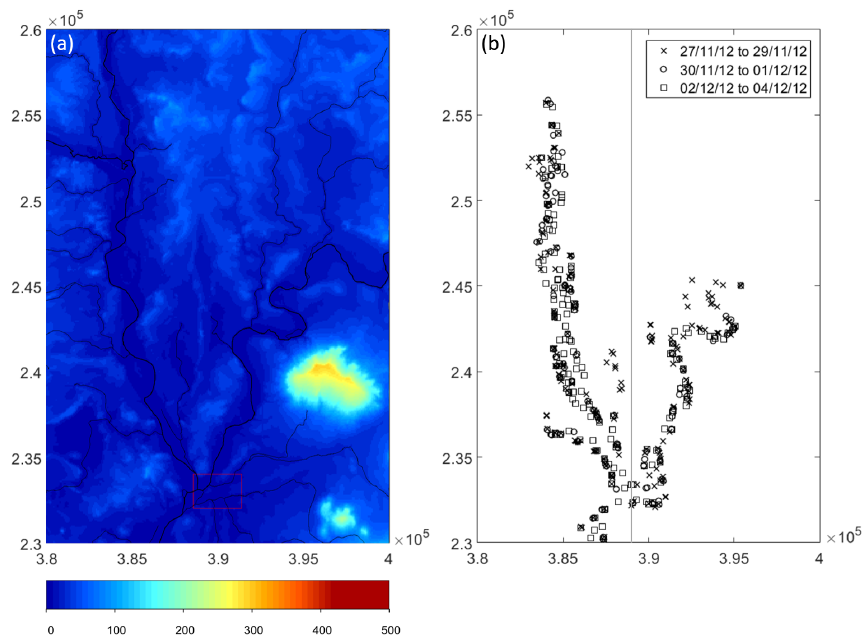
Figure 1. (a) Flood model domain where the colour bar denotes the height in metres and (b) position of SAR WLOs on OSGB 1936 British National Grid projection; coordinates in metres. For (b) the line denotes the west/east domain split discussed in Sect. 4.2, crosses: 27–29 November, circles: 30 November and 1 December, squares: 2 and 4 December.